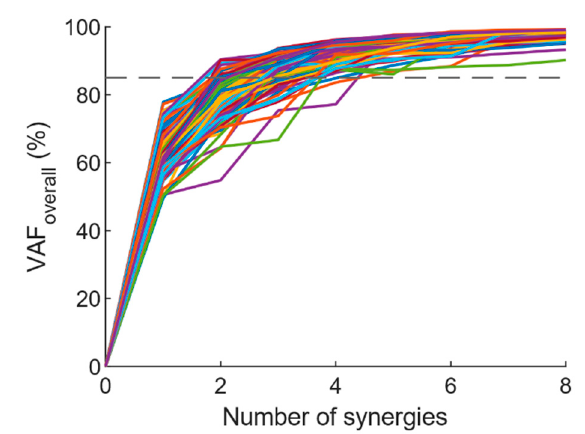
Figure 3. Overall Variation Accounted For (VAF overall ) with respect to the number of synergies extracted. The graph represents the VAF values for both unperturbed and left-inward perturbed walking for all combinations of walking speed and perturbation onset for all subjects.